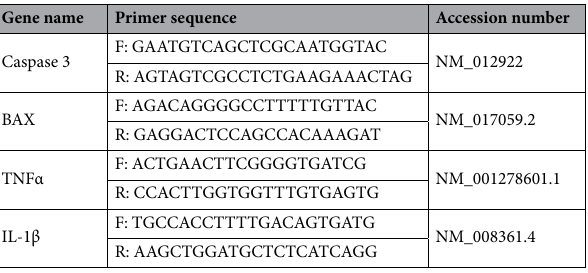
Table 2. Sequences of forward and reverse primers used for qRT-PCR